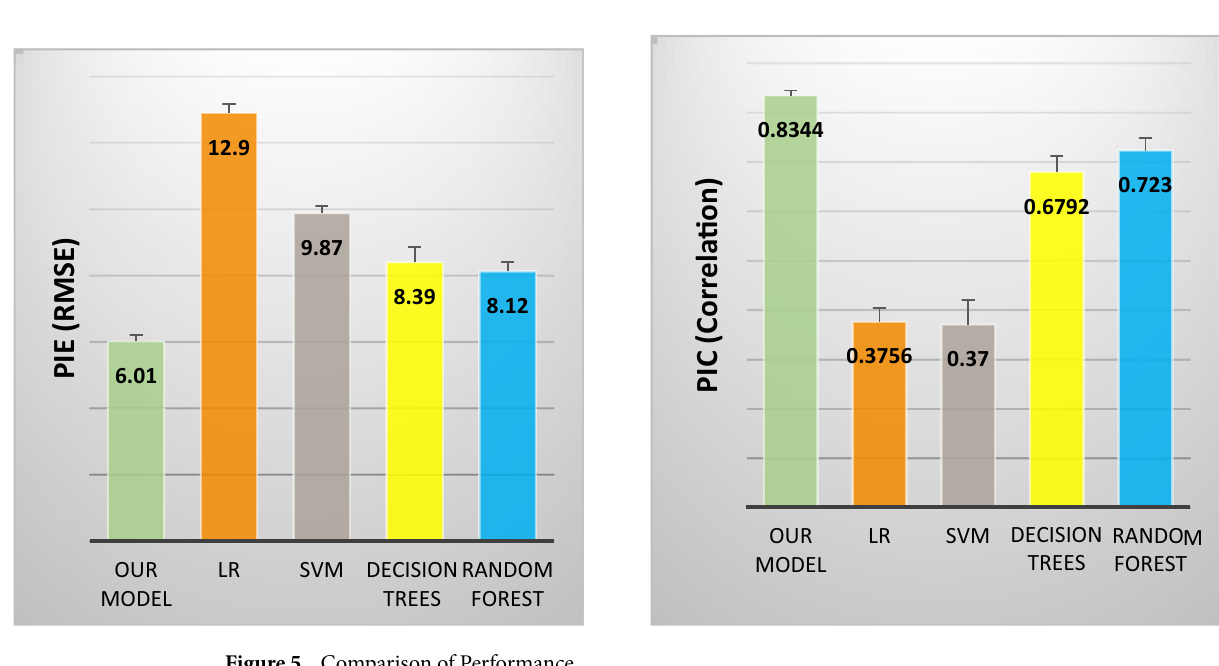
Figure 5. Comparison of Performance.